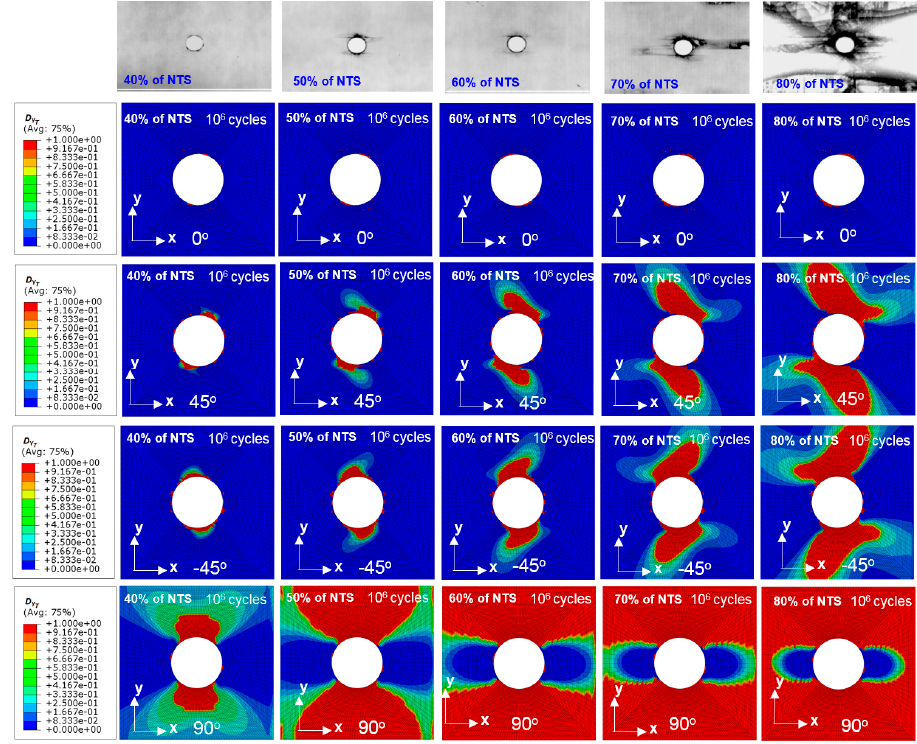
Figure 15. Reduction in stiffness G 12 in each ply of the OHT specimen after 10 6 cycles.